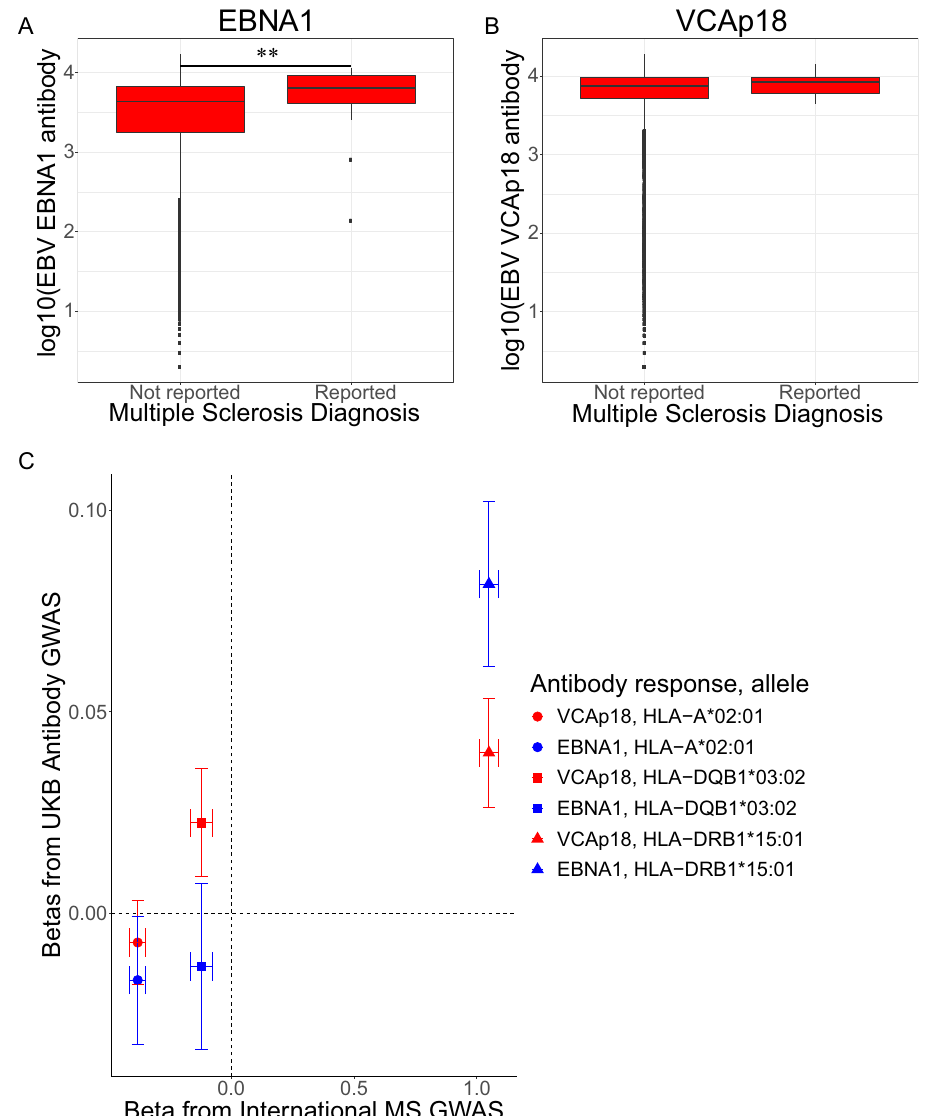
Fig. 3 EBV EBNA1 and VCAp18 antibody responses and associations with multiple sclerosis. Log 10 transformed antibody levels against EBNA1 ( A ) and VCAp18 ( B ) antigens were compared between groups in the UKB Multiplex Serology subset with or without self-reported diagnoses of multiple sclerosis (MS; 34 cases). Box plot centre line, median; box limits, upper and lower quartiles; whiskers, 1.5x interquartile range. ** P = 6.1×10 − 3 using linear regression. C The beta coef fi cients and 95% con fi dence intervals from the GWAS analyses of quantitative antibody responses against EBNA1 (blue) and VCAp18 (red) in the 9611 biologically independent individuals from the UKB subset ( y -axis) were compared to the coef fi cients and 95% con fi dence intervals from the largest available case-control GWAS of MS (17,610 cases and 30,129 controls; x -axis) for HLA alleles recognised to be associated with MS risk. The points representing beta estimates are shaped by imputed HLA